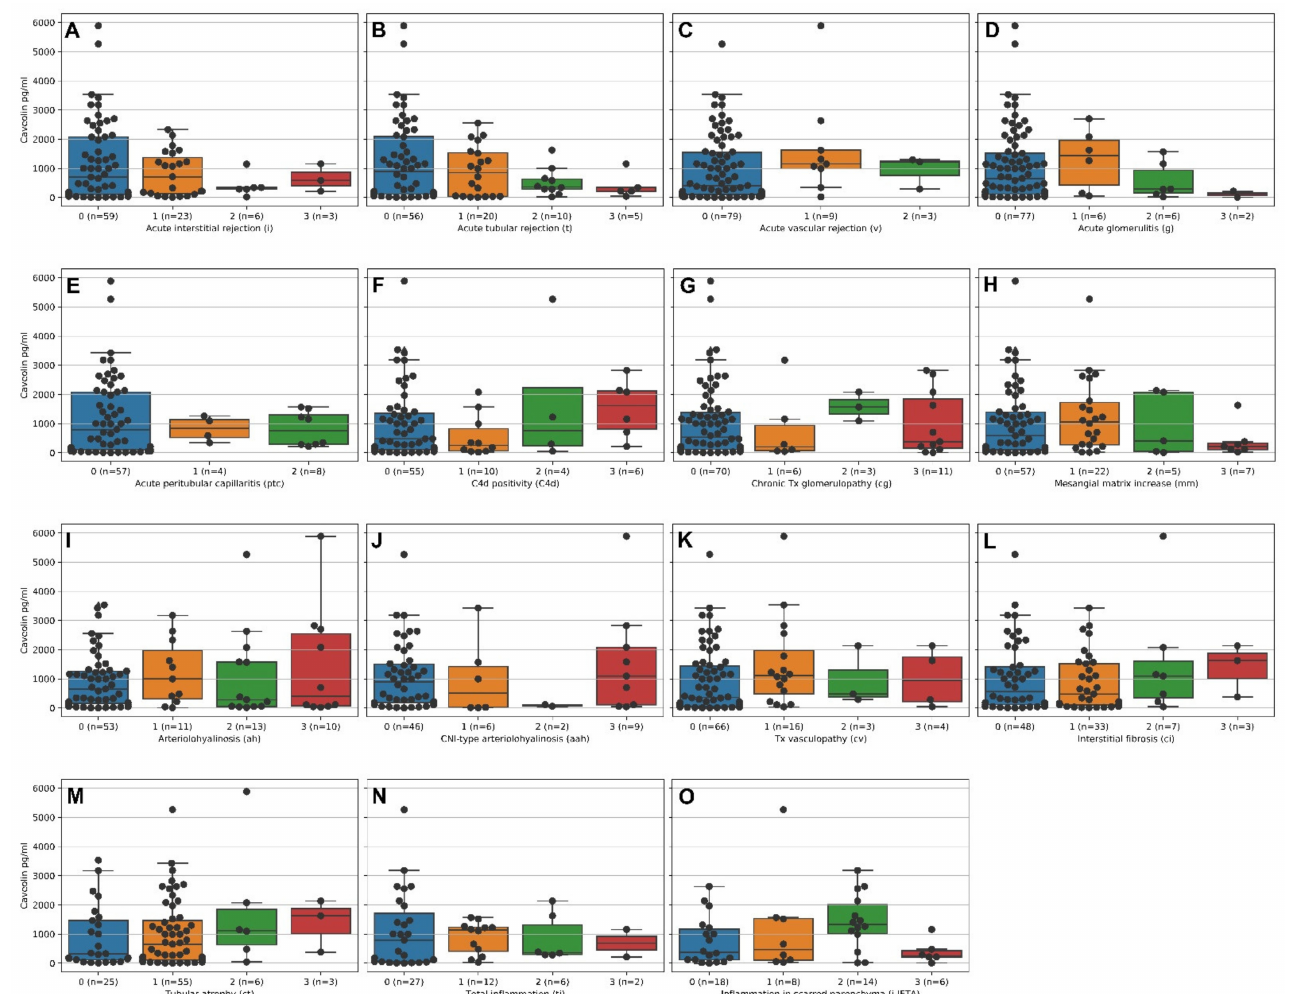
Figure 1. Bee-/Boxplots of Cav-1 serum levels in pg/mL vs. items according to the histological categories of the Banff classification. ( A ) Acute interstitial rejection, ( B ) acute tubular rejection, ( C ) vascular rejection, ( D ) acute glomerulitis, ( E ) acute peritubular capillaritis, ( F ) C4d positivity, ( G ) chronic transplant glomerulopathy, ( H ) mesangial matrix increase, ( I ) arteriolohyalinosis, ( J ) CNI-type arteriolohyalinosis, ( K ) transplant-vasculopathy, ( L ) interstitial fibrosis, ( M ) tubular atrophy, ( N ) total inflammation, ( O ) inflammation in scarred